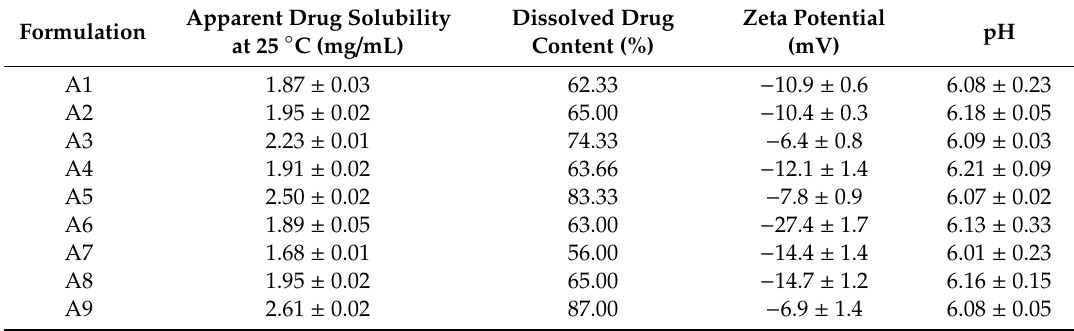
Table 3. Apparent drug solubility, zeta potential, and pH of nepafenac eye drop suspensions.